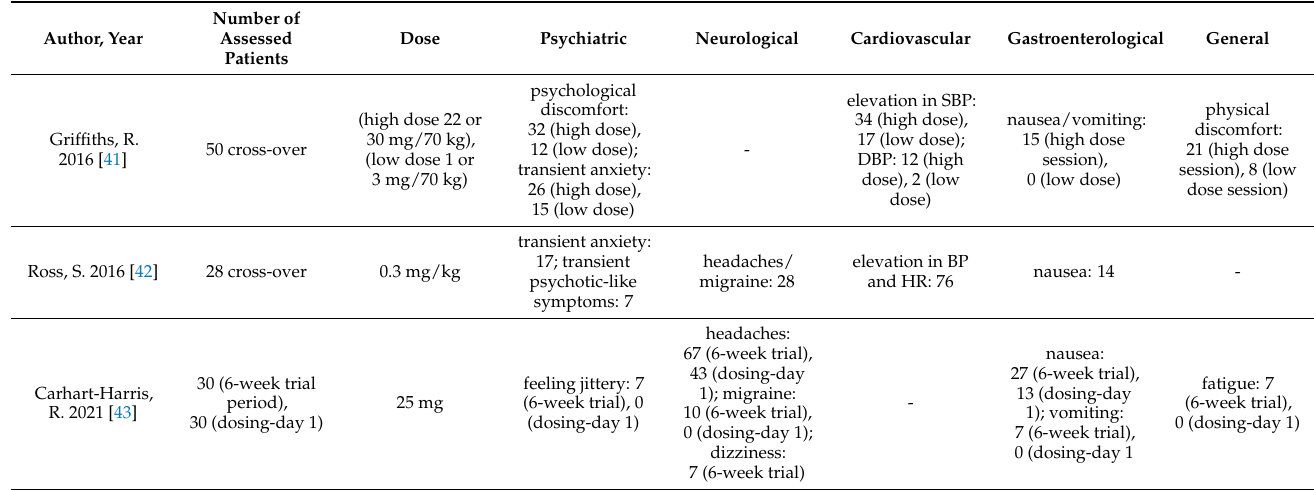
Table 7. Adverse effects by type occurred in more than 5% of patients during psilocybin